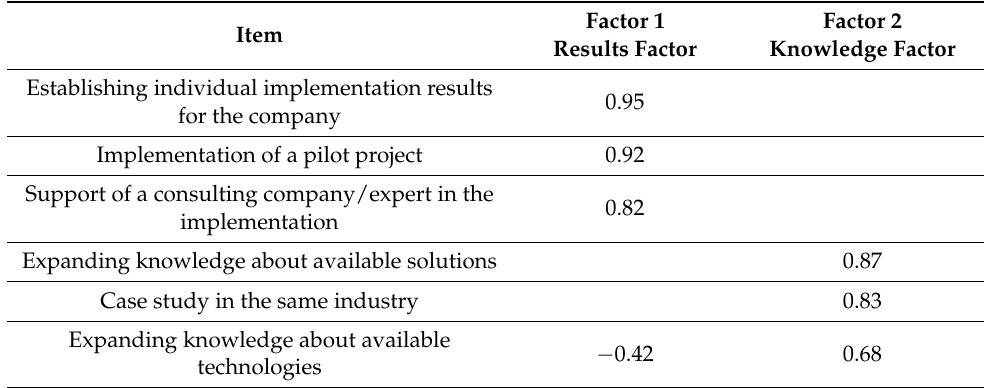
Table 17. Pattern matrix acquired in the principal component analysis regarding support for the decision-making process to implement Industry 4.0 solutions.